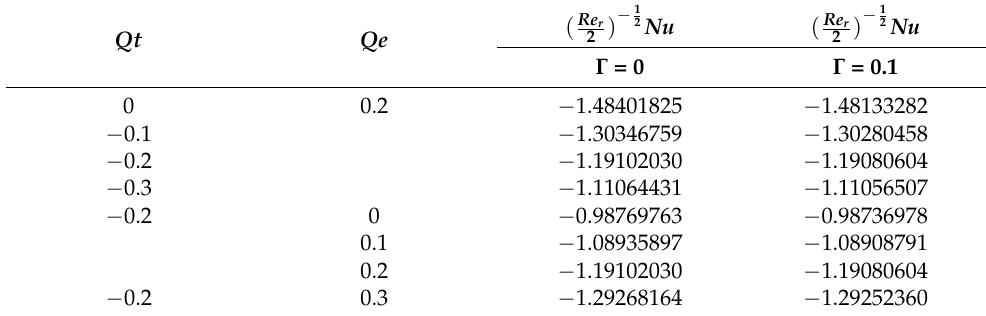
Table 6. The values of ( Re r 0.5, α = β = 0.2, δ = 0.5, Pr = 6, and n =